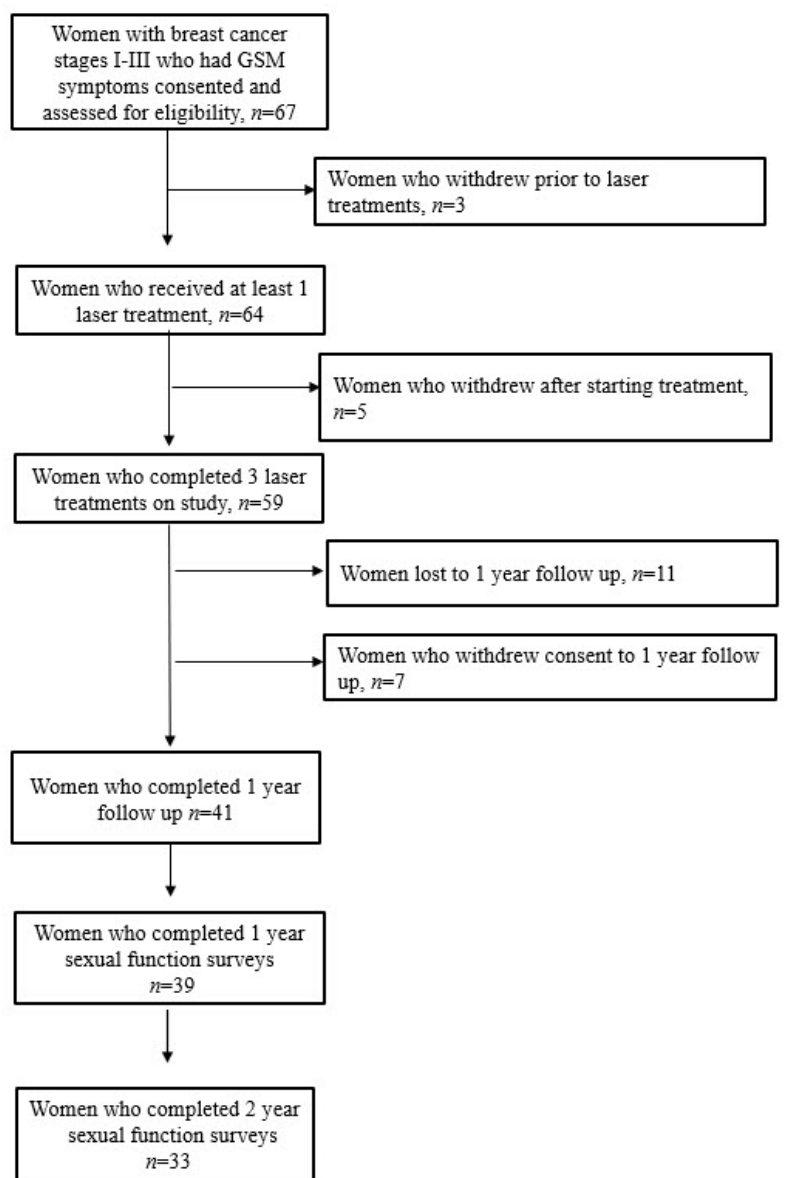
Figure 1. Consort diagram including long-term follow-up of study participants. GSM = Genitourinary syndrome of menopause .